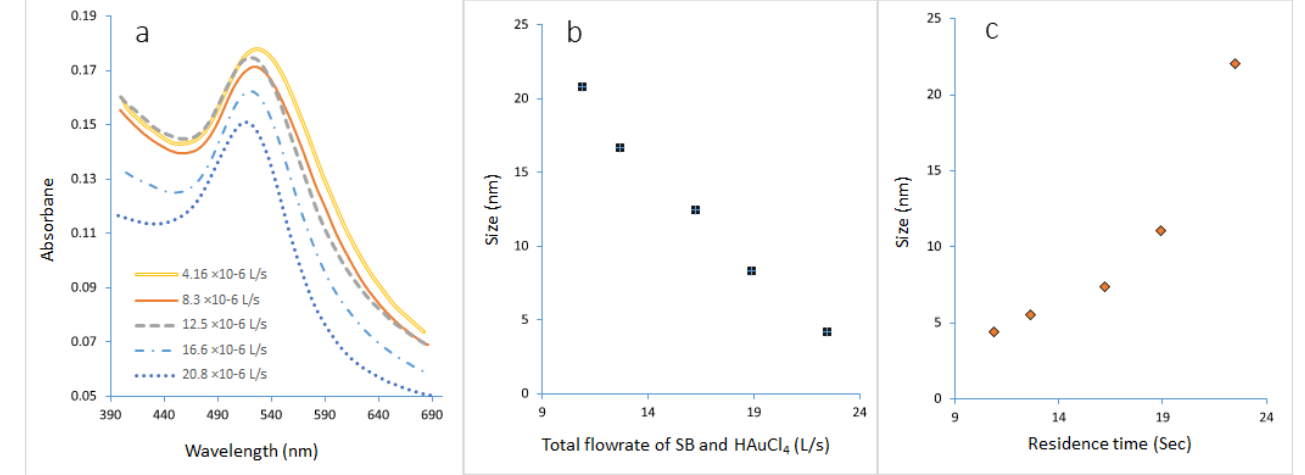
Figure 16 . ( a ) The UV-vis spectra of GNP samples prepared in a microreactor at various flow rates of (SB and HAuCl 4 ). ( b ) The impact of flow rate on the size of the final particle. ( c ) The impact of residence time on particle size. (Cons of SC, SB, and HAuCl 4 = 0.1 mM, T = 308.15 K, volumetric ratio of SB/AuCl 4 = 4:10, and pH = 3).